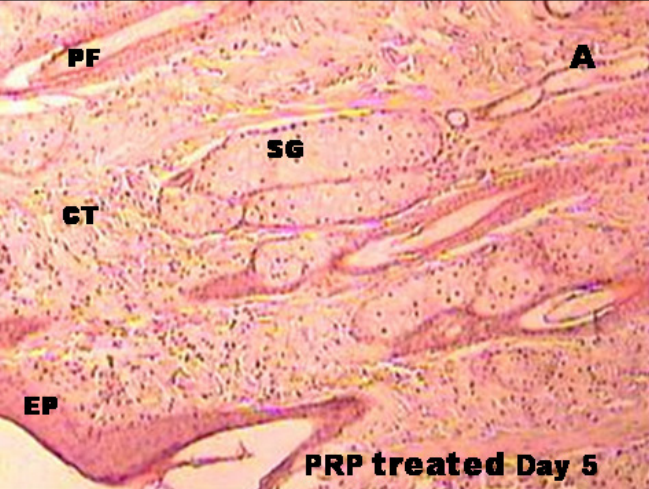
FIGURE 2 - Histological aspect of skin of the PRP group at Day 5 showing the epidermis (EP). The dermis shows connective tissue (CT) with sebaceous glands (SG) and pilous follicles (PF). 5X increase. HE